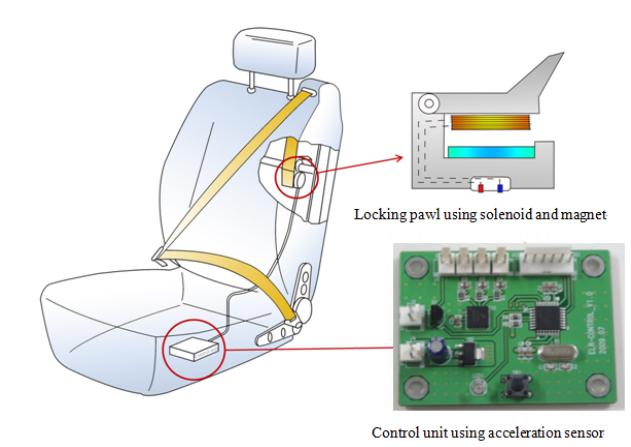
Figure 8. Overall system developed for this